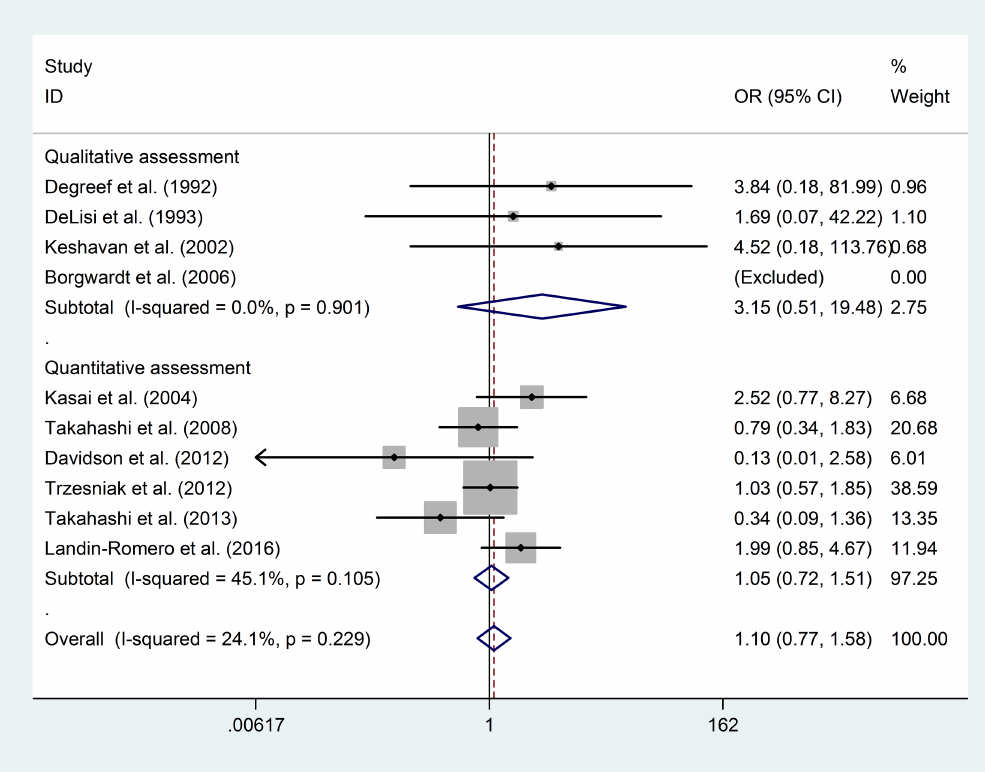
Fig 6. Prevalence of “large CSP” in the FEP patients and healthy